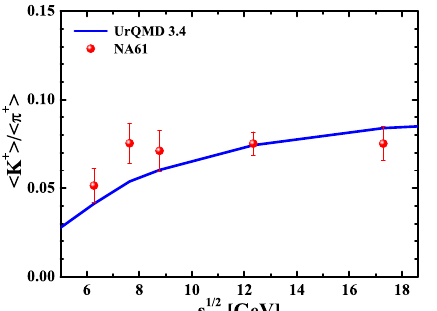
Figure 2. The UrQMD v3.4 predictions (line) for positive kaons over positive pions ratio in inelastic p + p interactions at CERN SPS energies in comparison to experimental data from the NA61 / SHINE Collaboration (symbols). The NA61 data points have been obtained from total positive kaon and pion yields published in Ref. [1], and their error bars have been taken as the corresponding statistical and systematic errors added in quadrature.